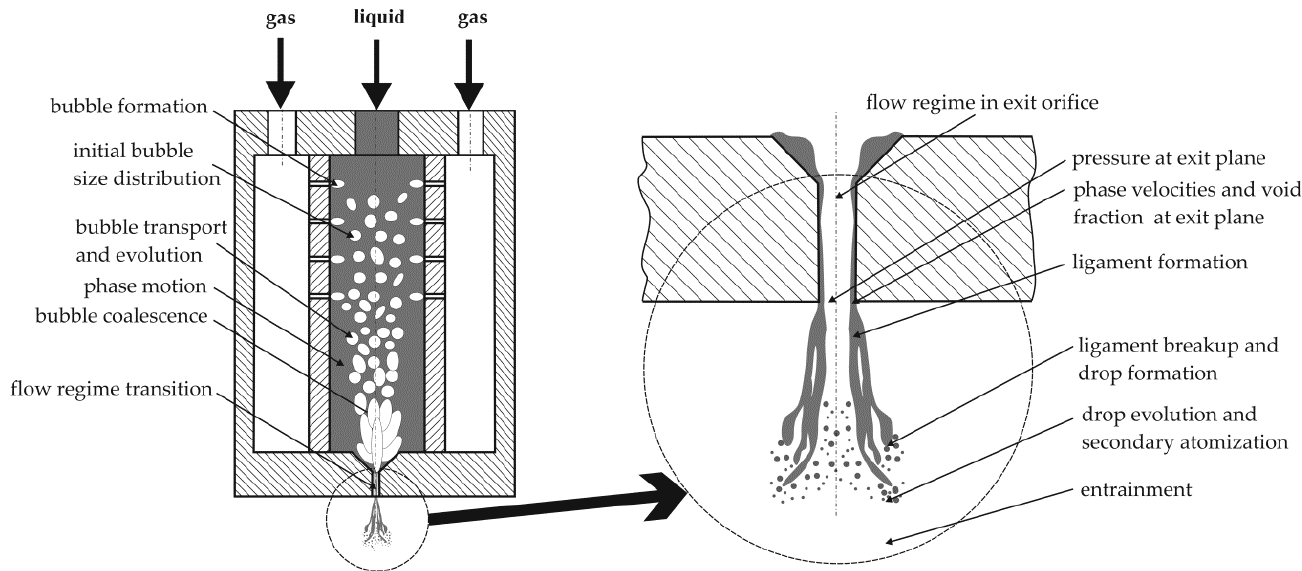
Figure 5. Schematic diagram of the two-phase atomization process in an effervescent atomizer [7,8]. Different flow structures are distinguished in the outlet opening: effervescent,